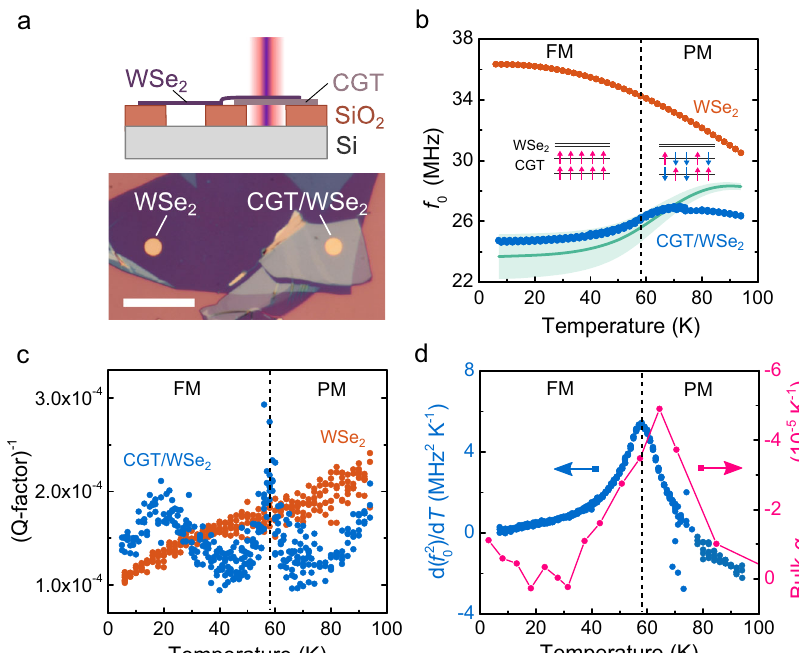
Fig. 3 Mechanical properties of a suspended CGT/WSe 2 (16.7 ± 0.3 nm/6.9 ± 0.1 nm) heterostructure membrane with a radius r = 2 μ m. a Top panel: Schematic cross-section of the sample consisting of the suspended CGT/WSe 2 heterostructure membrane and the reference WSe 2 membrane of the same fl ake. Bottom panel: Optical image of the sample with speci fi c membranes indicated. Scale bar: 16 μ m. b Measured resonance frequencies f 0 of the membranes in ( a ). Solid green line — the fi tted model of the resonance frequency of the CGT/WSe 2 heterostructure (Eq. (4)). Light green region — the allowed higher and lower boundary of the model due to the uncertainties in h 1,2 , E 1,2 and ð T Þ . Insets: Schematic of a CGT/WSe f 2 0 2 structure with the collinear and random magnetic spin arrangement in a bilayer of CGT in the 0 ferromagnetic (FM) and the paramagnetic (PM) phases respectively. c Dissipation factor Q − 1 as a function temperature. The origin of a broad ð Þ 2 0 feature at ~20 K remains unclear and is a subject of future studies. d Filled blue circles — d f of the CGT/WSe 2 heterostructure as a function of d T temperature. Connected magenta circles — the thermal expansion coef fi cient of bulk CGT 5 . The black vertical dashed lines in ( b – d ) indicate the ð Þ ¼ 58±0 : 5 K as determined from the peak position of d f 2 0 measured T (cid:3) C d T